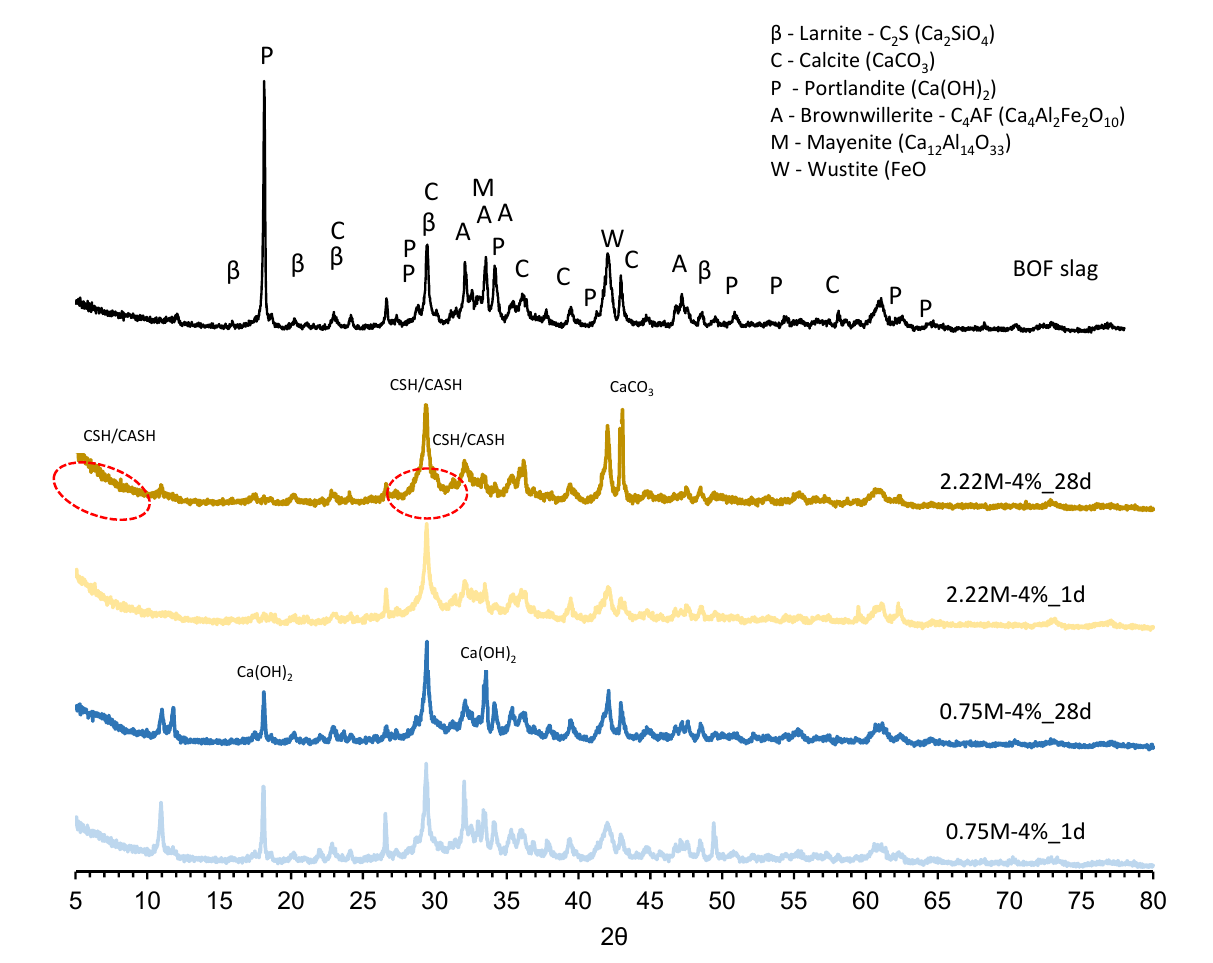
Figure 10. Comparison of the XRD patterns of 0.75M-4% (blue) and 2.22M-4% (yellow) at 1 and 28 days (dotted red circle: broad hump indicating amorphous phase structure).